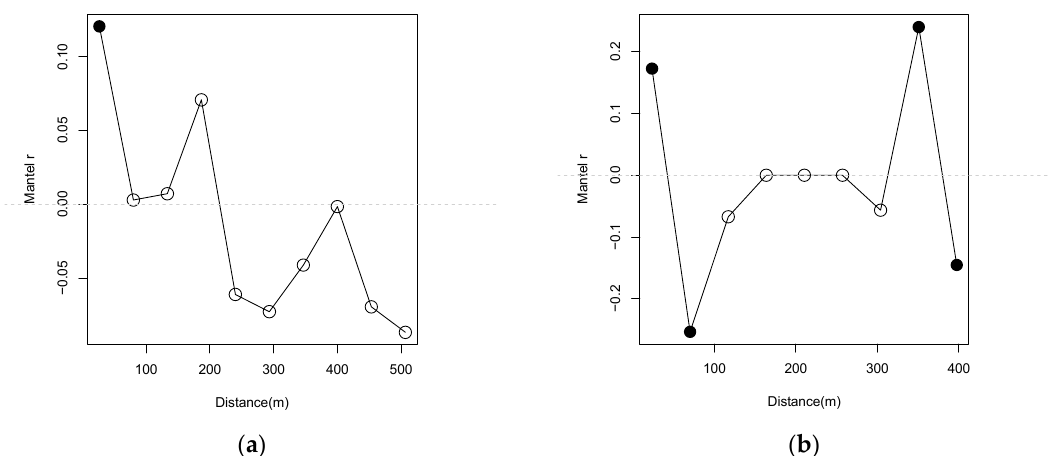
Figure 5. Mantel correlogram showing the strength of the correlation between spatial proximity and ectomycorrhizae for samples within different distance species composition classes in ( a ) Longli Forest Farm and ( b ) Hunan Botanic Garden. Points are plotted at the midpoint of each distance class. Solid circles represent significant correlations ( p < 0.05), and open circles show correlations that are not significantly different from zero ( p > 0.05).